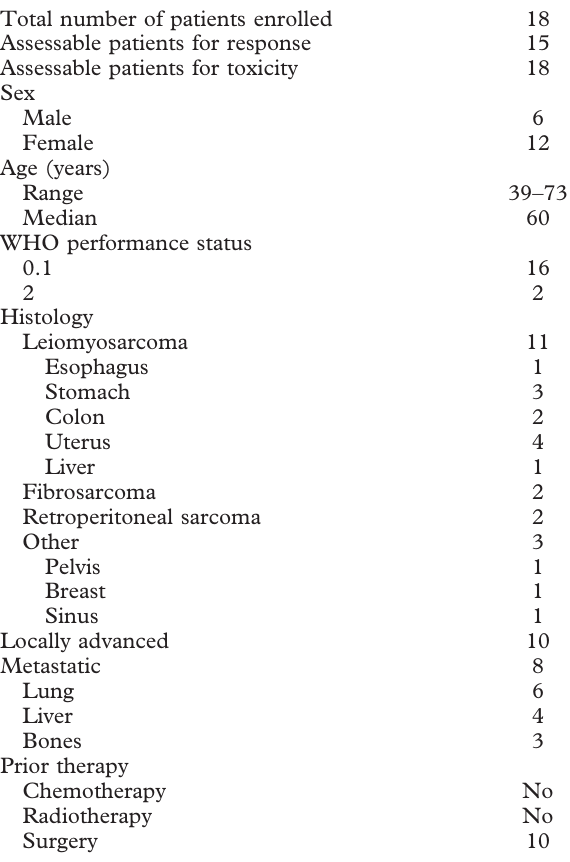
Table 1. Patients and disease characteristics Total number of patients